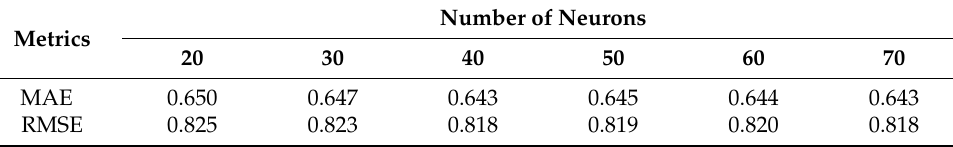
Table 7. Performance of DELCR with different numbers of neurons on the last layer for ML- 1M